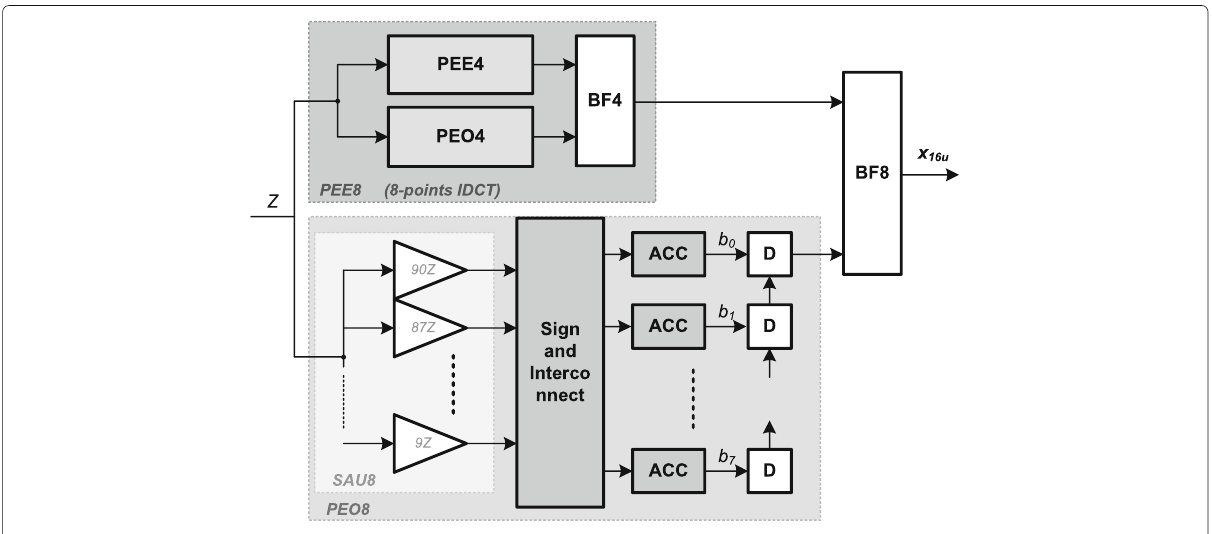
Fig. 5 Architecture of the 16-point IDCT as PEE16